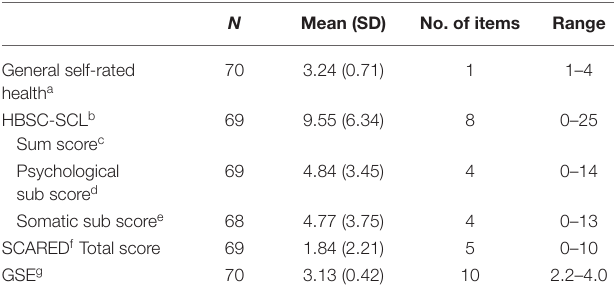
EILO sub-groups. a CLE scores missing for two responders. b No or mild obstruction, both levels. c Obstruction exceeding mild on glottic level only.